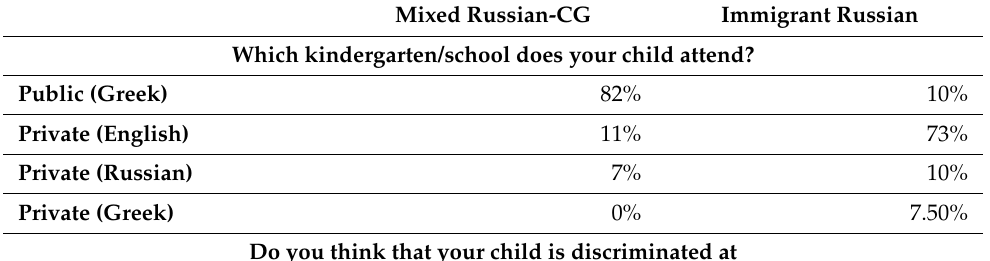
Table 3. Family type: schooling, and language